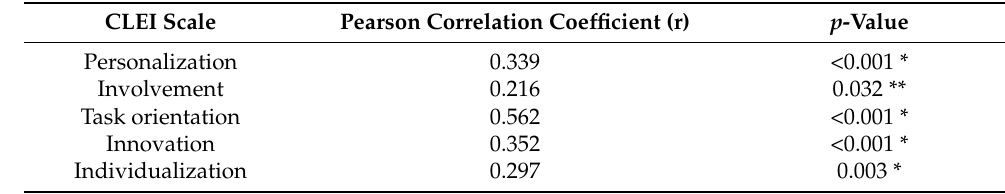
Table 4. Pearson correlation coefficients between the Satisfaction scale and the other scales of the CLEI-Actual.